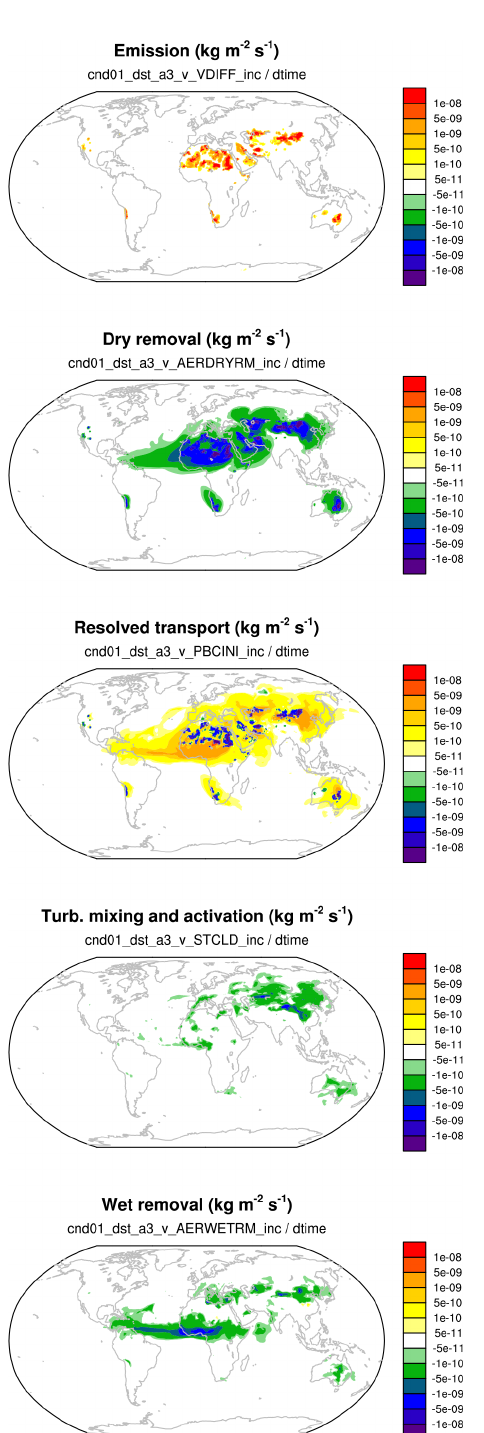
Figure 5. The 1-month mean tendencies of the vertically integrated coarse-mode dust burden (unit: kgm − 2 s − 1 ) attributed to different physical processes in EAMv1. The expressions given below panel titles indicate how the presented quantities are calculated from the model’s output variables.